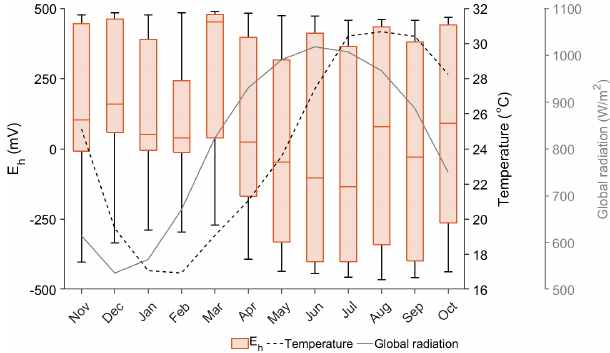
Figure 5. Seasonal changes in E h conditions as observed at 25cm depth at station 2 under long (7d) wetting periods. The dashed black line represents the monthly mean ambient temperature, and the solid grey line represents the monthly mean global radiation obtained from the Israeli Meteorological Service (IMS,